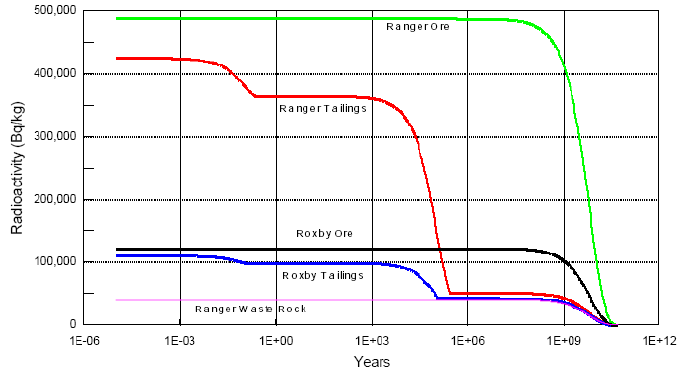
Figure 24. Radioactivity from uranium decay products in tailings, ore and waste rock. © 2000 Gavin Mudd, reproduced with permission from